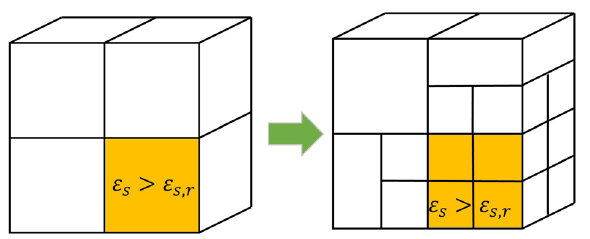
Figure 2. Local computational cell refinement is based on the volume fraction of solid